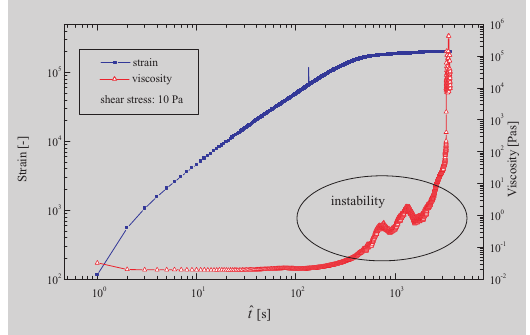
Figure 1 (left): Evolution in time of the dynamic moduli at constant frequency w = 1 s-1 in a gelation process for the samples under investigation (stress amplitude: t a = 0.5 Pa for sample S1, and t a = 10 Pa for sample S2, respectively). Sample S1 discloses a more sharp transition to the “solid” rheological behaviour. Figure 2 (right): Experimental creep test for sample S2 (a region of “instability” is observed in vicinity of the critical gel